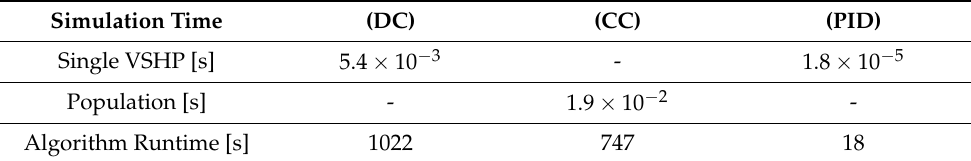
Table 2. Resultant Simulation